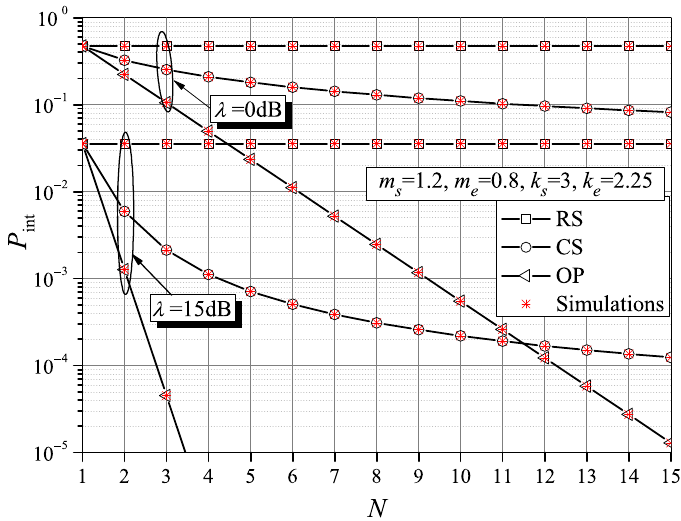
Figure 4. The intercept probability of the eavesdropped WSN vs. the network dimension. The impact of various fading/shadowing channel conditions over wiretap channels during the intercept events is shown in Figure 5. When the wiretap channel fading and shadowing parameters are modified, more pronounced effects are noticed when the CS scheme is applied. The required average MER gain to obtain P int = 10 − 5 is 2 dB in the case of OS policy and even 5 dB in the case of CS policy, when the channel condition parameters increase from m e = 1.09, k e = 2.25 to m e = 2.09, k e = 3.25. This confirms that favorable wiretap channel conditions, as well as the favorable main channel conditions, also degrade the intercept probability. Even RS has shown visible dependence on the wiretap channel condition change.